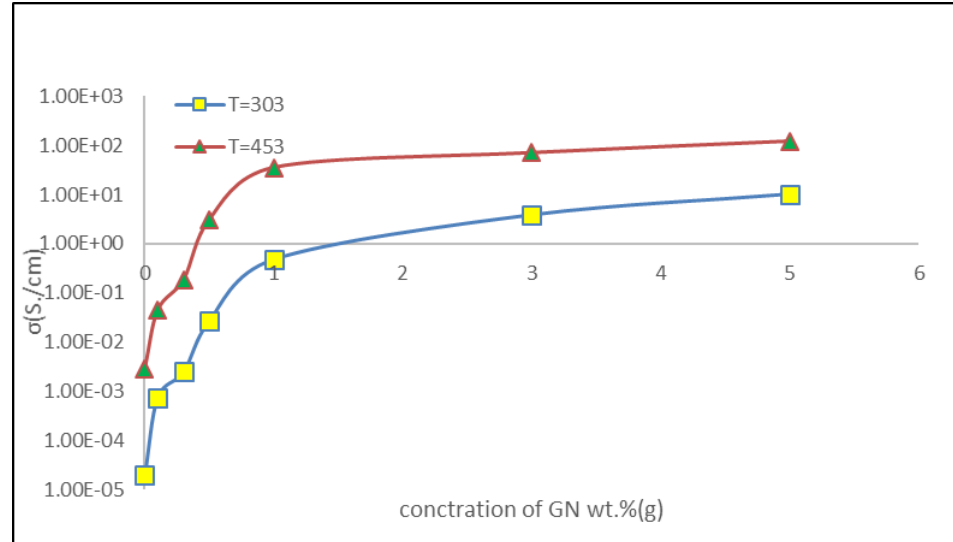
Fig.12: The variation D.C electrical conductivity with GN wt.% concentration.